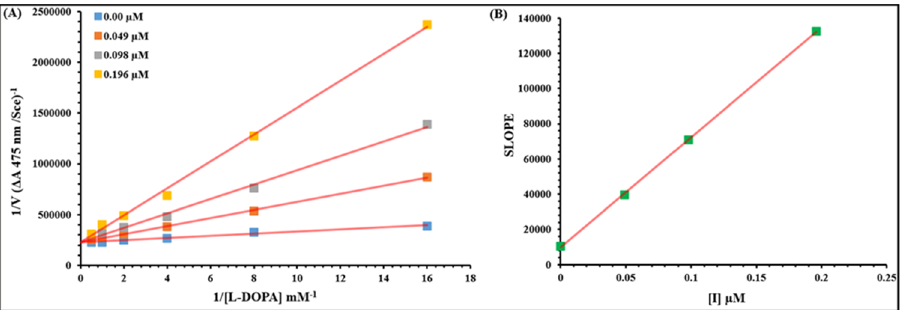
Figure 4. ( A , B ). Lineweaver–Burk plots for the inhibition of tyrosinase in the presence of compound 9h . ( A ) Concentrations of 9h were 0.00, 0.049, 0.098, and 0.196 µM, respectively. Substrate L-DOPA concentrations were 0.0625, 0.125, 0.25, 0.5, 1, and 2 mM, respectively. ( B ) The insets represent the plot of the slope versus inhibitor 9e concentrations to determine inhibition constant. The lines were drawn using linear least squares fit. Green dots represented the concentrations with the value of slope.